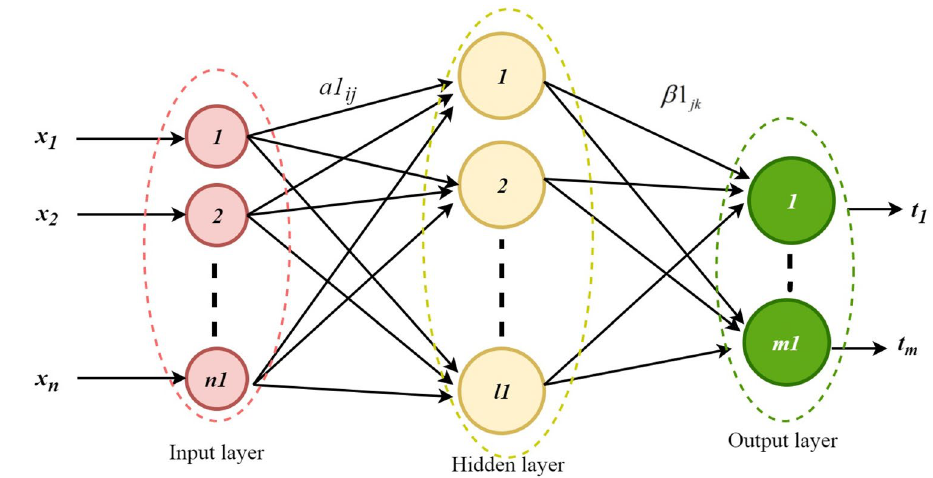
Fig. 6 Topology of extreme learning machine